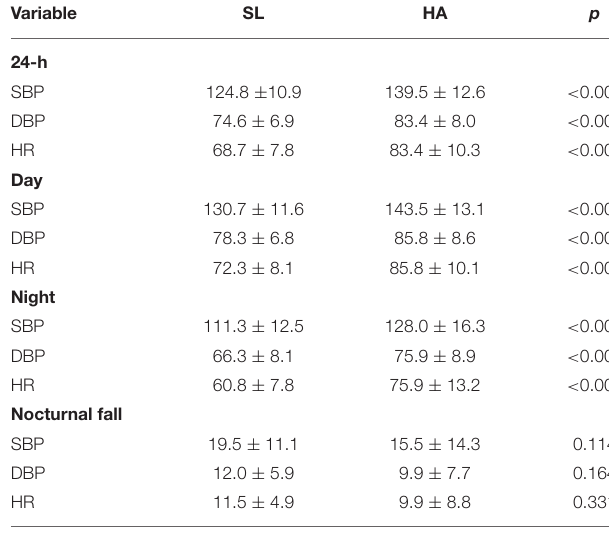
TABLE 3 | HR and BP variables from 24-h ABPM at SL and HA.